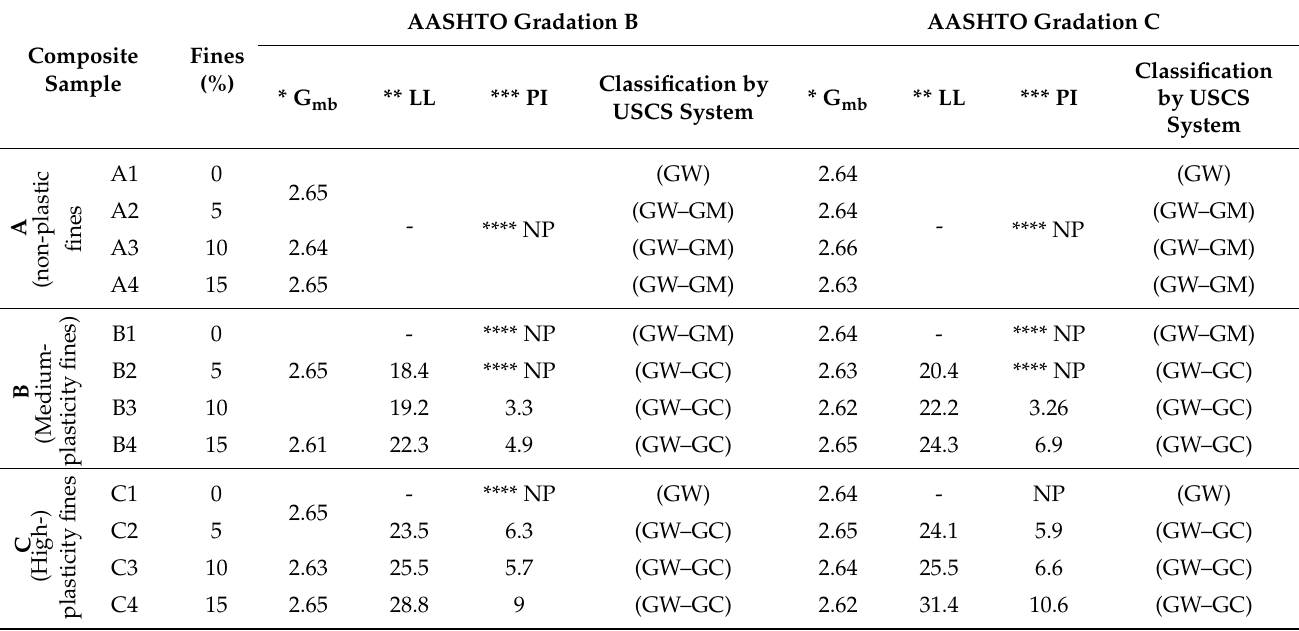
Table 2. Laboratory test results for the composite